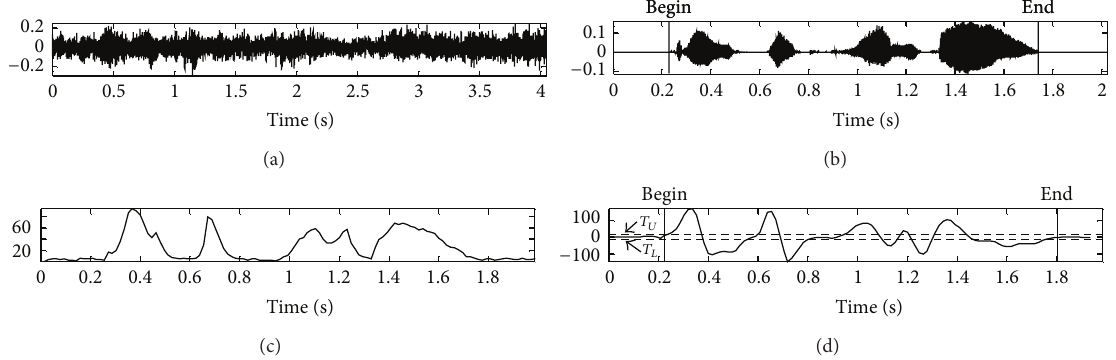
Figure 9: Results of the proposed algorithm in a babble - noise environment: (a) noisy speech signal at SNR − 5dB, (b) clean speech signal, (c) the proposed feature, and (d) edge detection filter output based on the proposed feature.